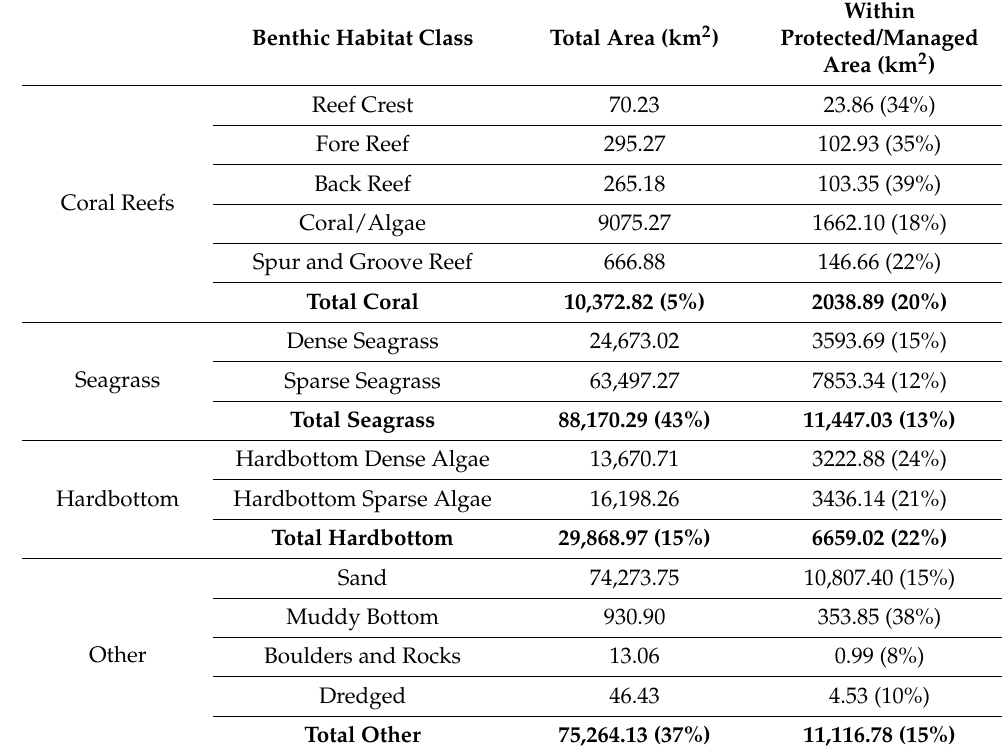
Table 4. Total area (km 2 ) for each benthic habitat class within the shallow marine zone (<30 m depth) of the Insular Caribbean and corresponding area and percentage within declared marine protected or managed